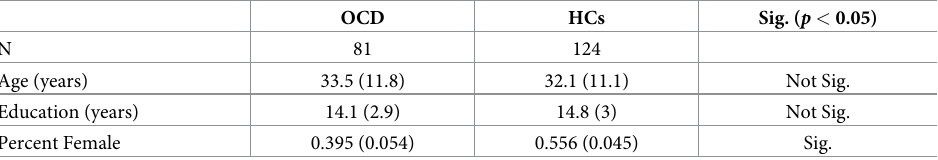
Table 1. Demographic variables in OCD patients and HCs. Means (standard deviations in